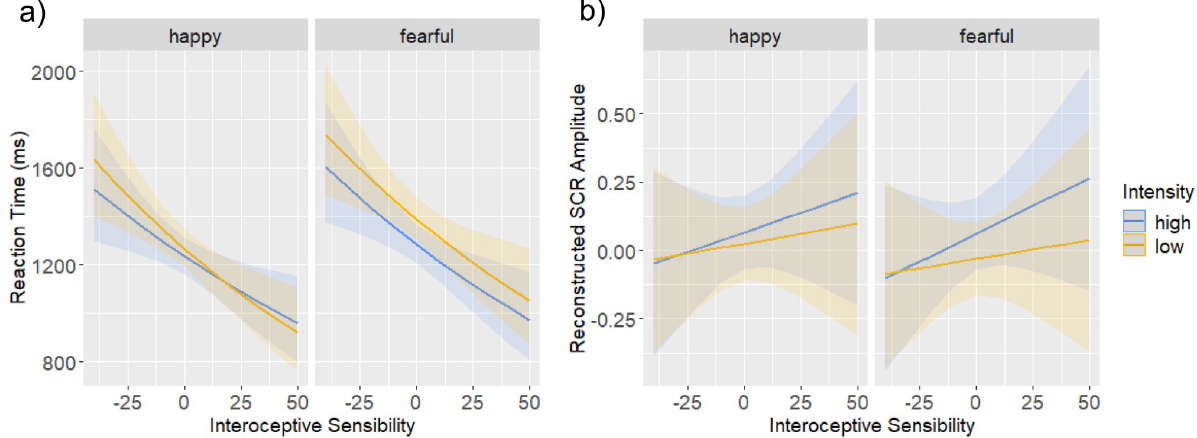
Fig 2. Effects of valence and intensity. Marginal effects of valence (happy, fearful) and intensity (high, low) as a function of interoceptive sensibility assessed by the MAIA-2 questionnaire (Mehling et al., 2018) on a) reaction time and b) skin conductance response (SCR). The solid lines depict the regression fit, and the shaded areas show the 95% confidence